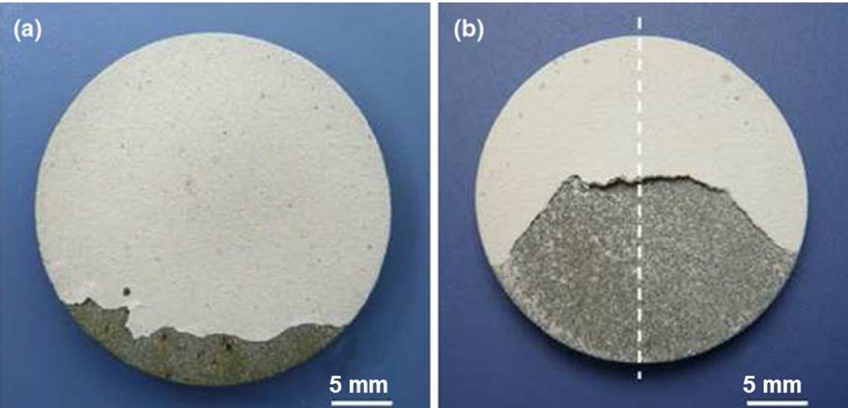
Fig. 82 Comparison of lifetime during the thermal shock test: (a) conventional TBCs with 200 cycles and (b) nanostructured TBCs with 530 cycles. Reproduced with permission from Ref. [426], © ASM International